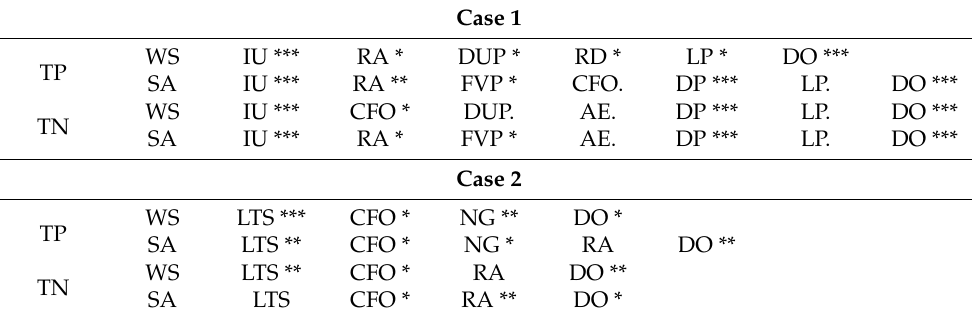
Table 4. Variables considered in total nitrogen (TN, µ g/L) and total phosphorus (TP, µ g/L) models in Cases 1 and 2, for winter-summer (WS) and spring-autumn (SA) sampling. The significance of each variable in both models is specified: * significant, p < 0.10, * significant, p < 0.05), ** significant, p < 0.01), *** significant, p < 0.001.